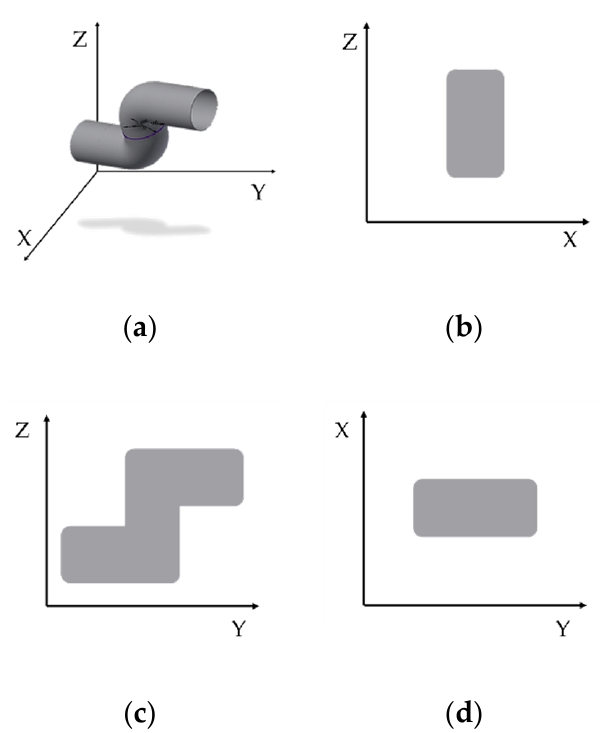
Figure 4. ( a ) Three-dimensional rehabilitation model rendered in virtual space, and view of the model along the ( b ) XY axis, ( c ) YZ axis, and ( d ) XZ axis in a two-dimensional plane.